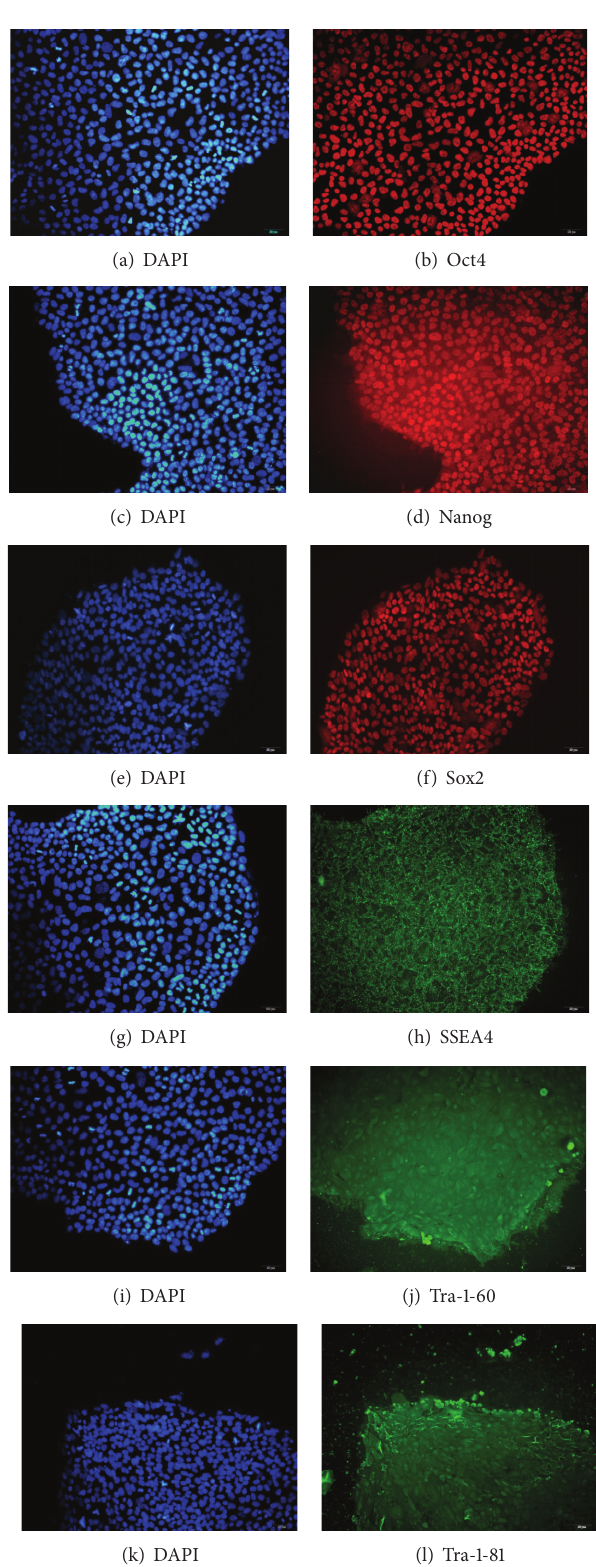
Figure 5: Detection of specific markers of hESCs cultured on fixed xeno-free ECM after 25 passages. ((a), (c), (e), (g), (i), and (k)) hESCs nuclear staining with DAPI; ((b), (d), (f), (h), (j), and (l)) hESCs with staining of Oct4, Nanog, Sox2, SSEA4, Tra-1-60, and Tra-1-81,